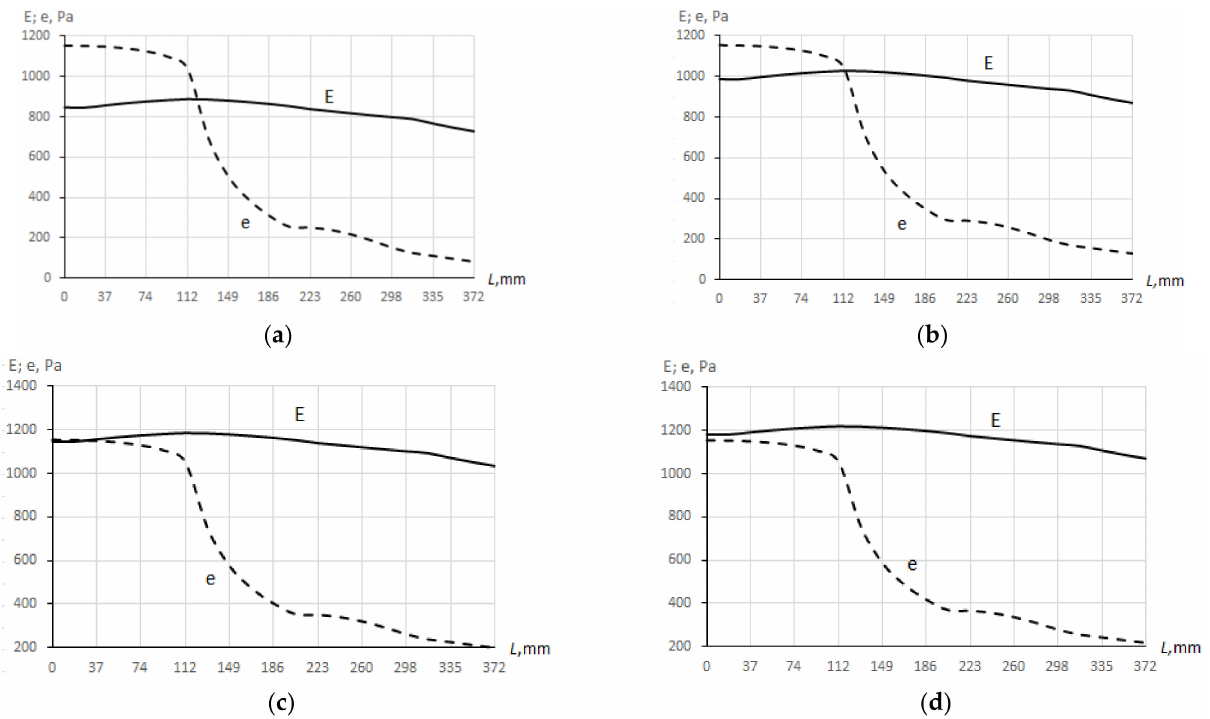
Figure 12. Graphs of changes in the partial pressure of water vapor e and partial pressure of saturated water vapor E in the area of metal structures that are not in contact with the attic air at a relative humidity in the attic of 50% and its temperature: ( a ) − 15 °C; ( b ) − 10 °C; ( c ) − 5 °C; and ( d ) − 4 °C.